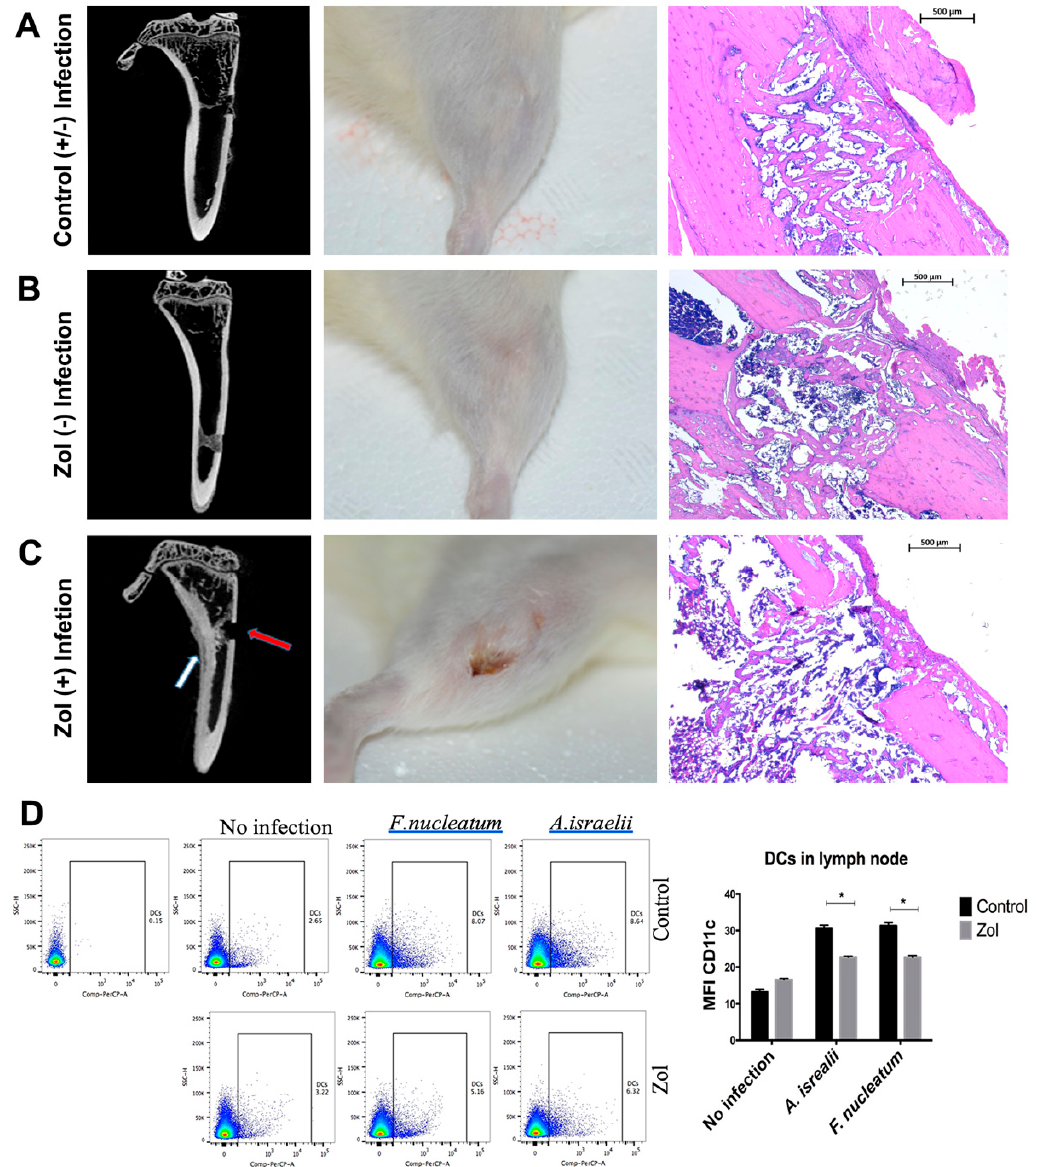
Figure 3. Development of osteonecrosis in a tibial model requires both zol treatment and the pre-existence of oral bacteria. ( A ) A gtibial defect in untreated (control) rat tibia with or without pre-existing local infection with A. israelii : left panel—a micro CT showing signs of normal wound healing and cortical bridging; middle panel—a clinical picture showing complete soft tissue healing; right panel—a representative histological photomicrograph showing adequate defect healing and bone fill. ( B ) A tibial defect in zol-treated rats without pre-existing A. israelii local infection: left panel—a micro CT showing normal gap bridging and callus filling with no signs of a periosteal reaction or cortical thickening, comparable to the control rats; middle panel—a clinical picture showing complete soft tissue healing; right panel—a representative histological photomicrograph showing adequate defect healing and bone fill. ( C ) A tibial defect in zol-treated rat tibia with pre-existing infection: left panel—a micro CT showing signs of osteolysis, a lack of cortical bridging (red arrow) and an inflammatory periosteal reaction (white arrow); middle panel—a clinical image showing delayed wound healing and a persistent dehiscence, exposing the underlying necrotic bone surfaces, similar to MRONJ; right panel—a representative histological photomicrograph showing adequate defect healing and bone fill. ( D ) A flow cytometry scattergram and corresponding summary graph showing the MFI in the DC population in the popliteal and inguinal lymph nodes in the control (upper panel) and zol-treated (lower panel) rats with F. nucleatum , A. israelii and no infection. Statistical analysis done by multiple T test (* p <